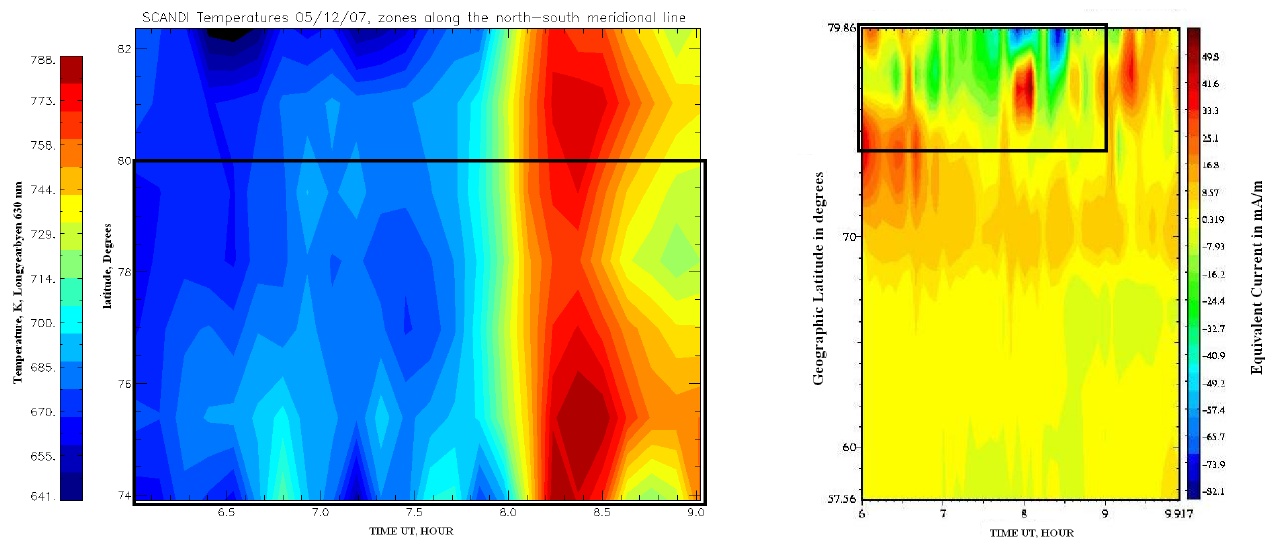
Fig. 7. (a) SCANDI neutral temperatures from the meridional chain of zones in keogram format showing the spatial distribution and time evolution. (b) Equivalent currents from the MIRACLE magnetometer chain are shown by latitude and time with large currents indicated around 08:00UT. Both plots have overlapping coverage in latitude and time highlighted.